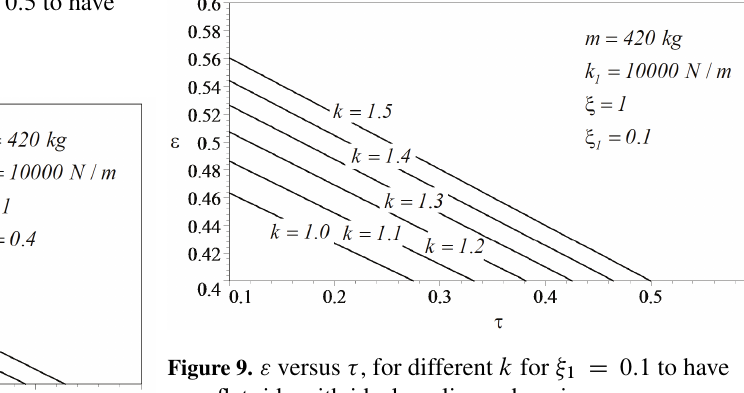
Figure 9. " versus (cid:28) , for different k for (cid:24) 1 D 0:1 to have near flat ride with ideal nonlinear damping.